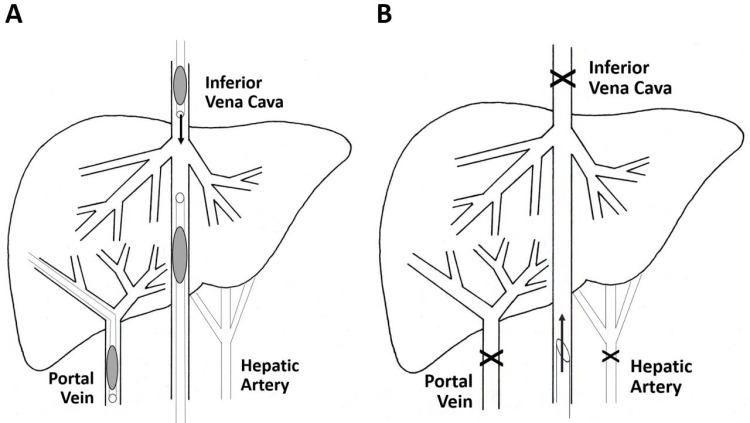
Open and closed endovascular catheterization procedure.The endovascular closed procedure is represented in Fig 1A. A schematic representation of the procedure is provided. An 8Fr balloon introducer and a 10Fr balloon catheter were placed in the vena cava, limiting entrance to the liver. Another transhepatic 10Fr balloon catheter was placed in the portal vein to block outflow. Fig 1B provides a schematic representation of the surgery closed model. After midline laparotomy, the liver is exposed and its vasculature (veins and artery), except the infrahepatic inferior vena cava, is referenced and ligated, thus completely sealing the organ. Retrograde gene transfer is performed through an 11 Fr catheter.